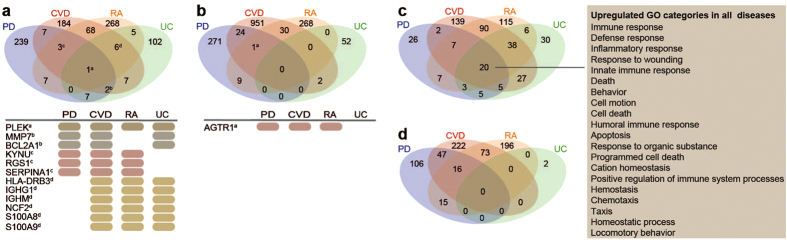
Comparative gene expression and GO analysis for periodontitis, CVD, RA, and UC.Venn diagrams representing the numbers of common and specific (a) up-regulated and (b) down-regulated genes in periodontitis (PD), cardiovascular disease (CVD), Rheumatoid Arthritis (RA), and ulcerative colitis (UC), together with the gene names for the genes common to all or three diseases. (c) Venn diagram demonstrating the numbers of common and specific up-regulated gene ontology (GO) categories including the list of 20 up-regulated GO categories common in PD, CVD, RA, and UC. (d) Venn diagram showing the numbers of common and specific down-regulated GO categories in all diseases.